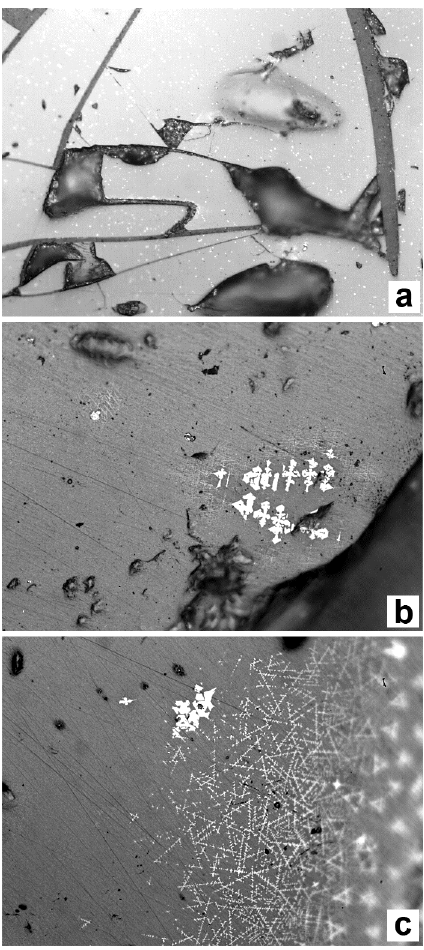
Fig. 1 . Microstructure of samples cooled with the rate 900 К /s ( а ) and annealed at 1023 К within 5 (b) and 60 min (c) ( х 500)